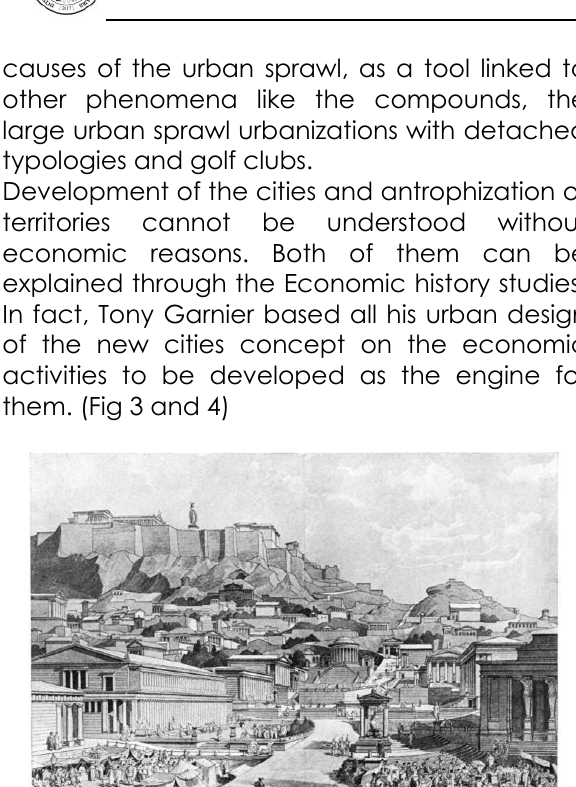
Figure 3. Tony Garnier, UneCitéindustrielle. Ètude pour la construction des villes, 1917.